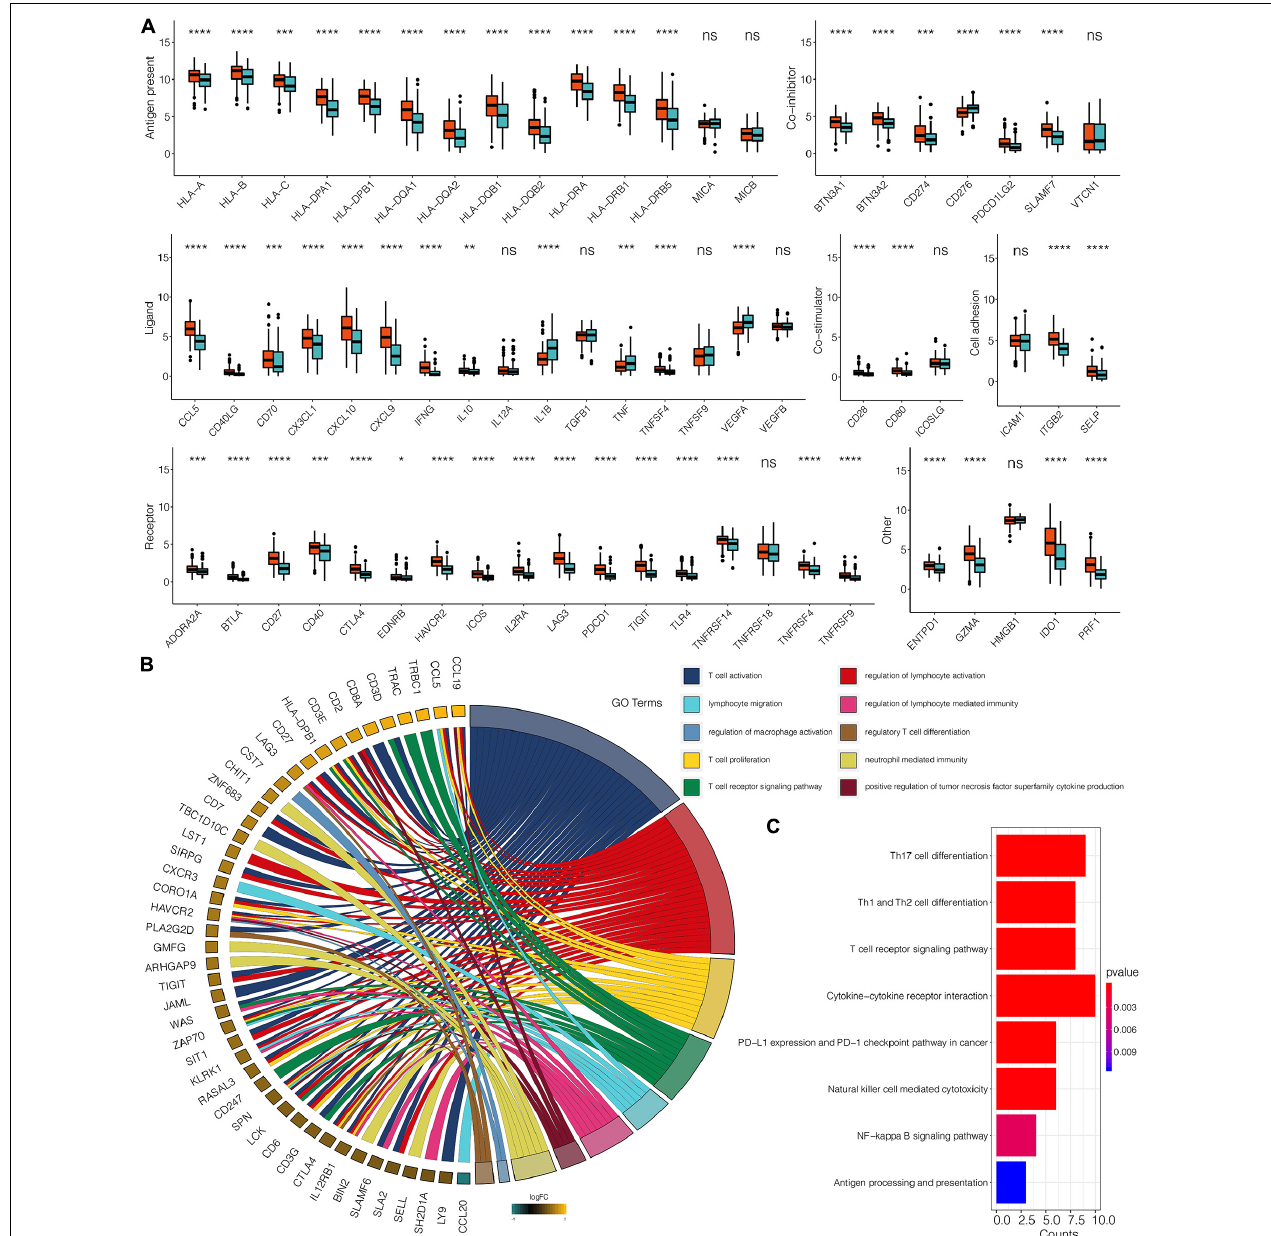
FIGURE 4 | (A) The expression pattern of seven types of immune checkpoints in TME gene clusters for the TCGA dataset. (B) The GO enrichment analysis of the 98 DEG for TME signatures. (C) KEGG enrichment analysis of the 98 DEG for TME signatures. *, P < 0.05; **, P < 0.01; ***, P < 0.001; ****, P < 0.0001; ns, not statistically